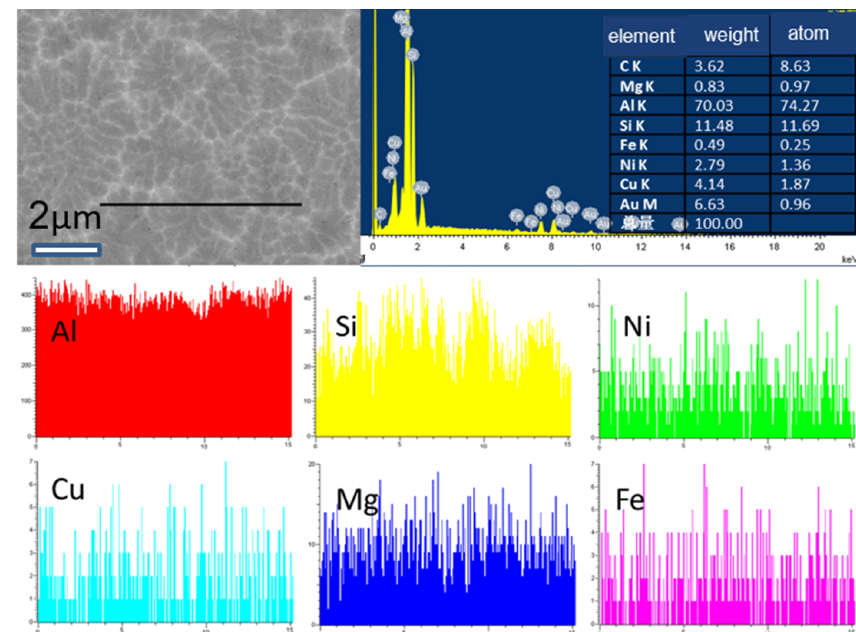
Figure 6. SEM analysis in the Al-13Si-4Cu-1Mg-2Ni alloy solidified with cooling rate of 1.5 × 10 5 °C/s.